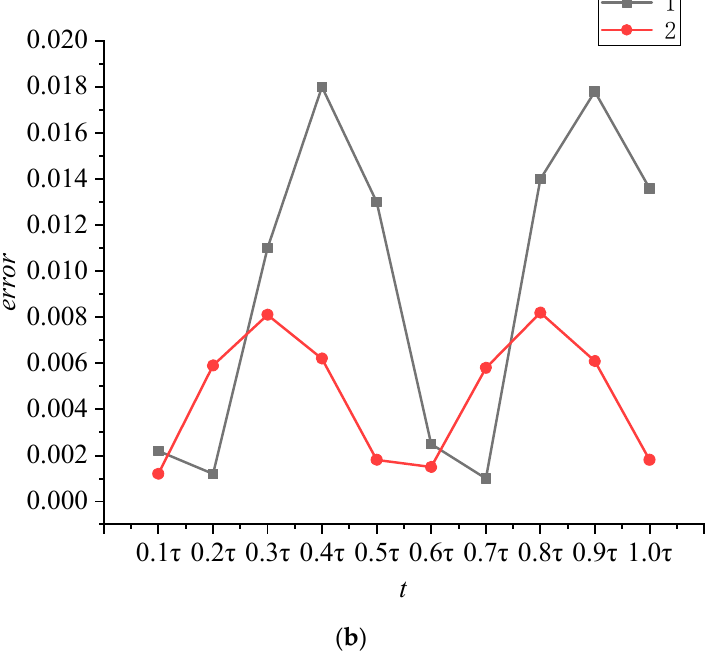
Figure 17. Numerical solution of regular hexagon and circular tube ( a ) temperature distribution ( b ) error analysis.